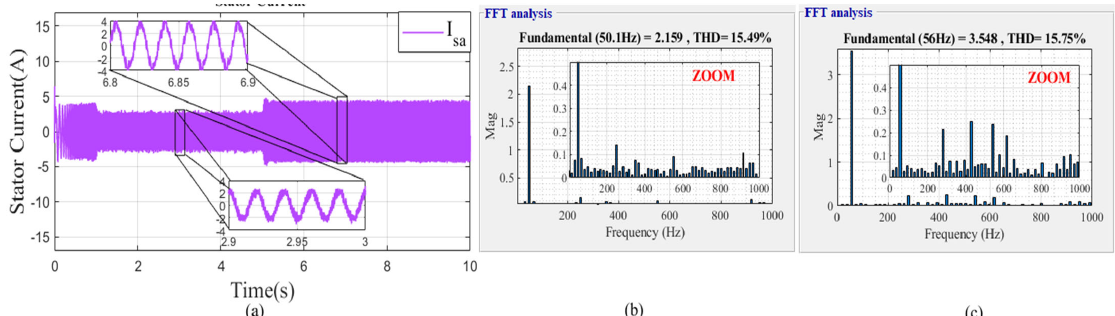
Figure 33. Performance with OR bearing defect of IM with DTC control: ( a ) Stator current and ( b ) THD at no ‐ load and ( c ) THD with load (5 Nm).